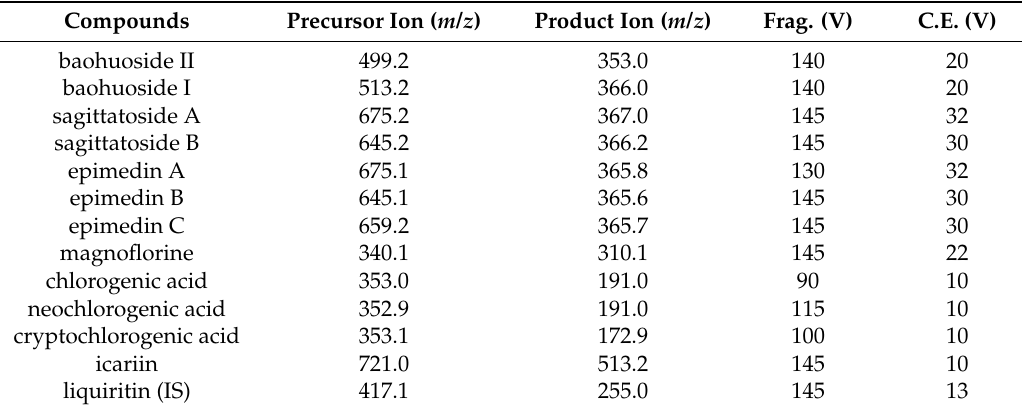
Table 6. Mass spectra properties of 12 analytes and